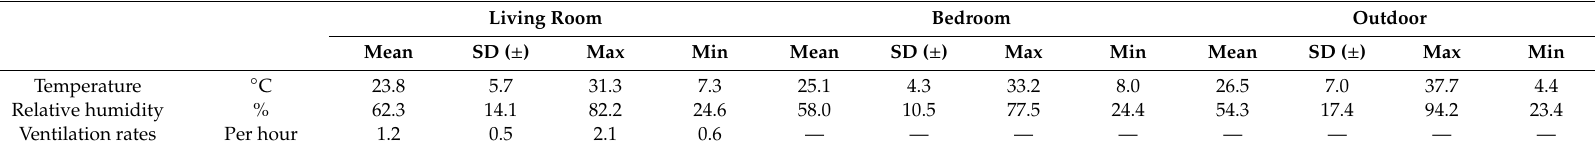
Table 1. Indoor environments.